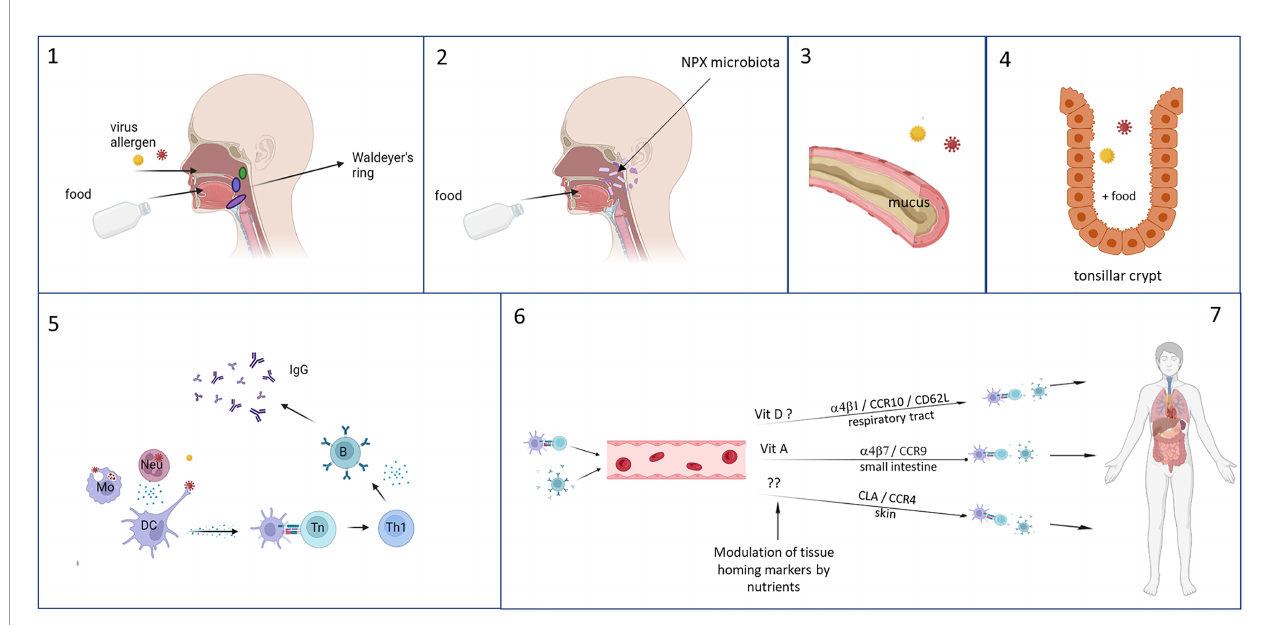
FIGURE 3 | Foods are ingested and enter the gastrointestinal tract via the mouth and respiratory pathogens via the nasal cavity, both ending up in the tonsils of Waldeyer ’ s ring (1). Especially in infants, re fl ux can cause a direct interaction of the foods with the nasopharyngeal microbiota and in fl uences their composition (2). Mixing of the food with saliva and mucus (based on charge and polarity) enhances the residence time in the nasopharynx (3), and as a result the still undigested food and respiratory pathogens can interact with each other and the immune tissues in the tonsil, where stasis occurs in the crypts which further lengthening the duration of interaction (4). Local immune responses can occur, during which can be modulated by the food components (5). Immune cell recirculate and home to different tissues – especially to the upper respiratory tract because of instruction by stromal cells in the tonsils – which is determined by the expression of homing receptors. This can also be in fl uenced by food components, selectively homing, for example by vitamins, resulting in increased memory responses in the local tissues of the upper respiratory tract (6). This fi gure was created with